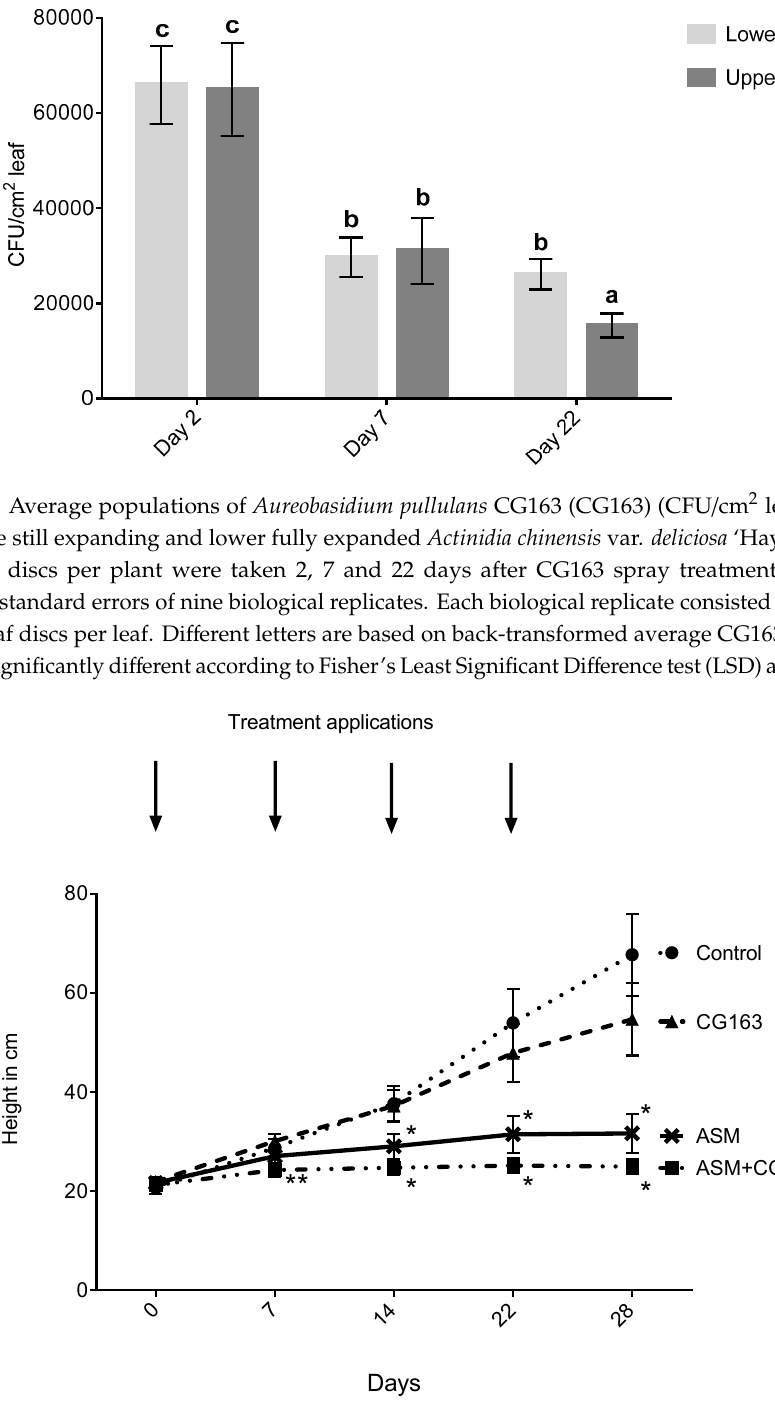
Figure 4. Plant growth of Actinidia chinensis var. deliciosa ‘Hayward’ potted plants treated with acibenzolar-S-methyl (ASM), Aureobasidium pullulans strain CG163 (CG163), combination of ASM and CG163 (ASM + CG163) or untreated (control). Weekly application of the treatments was started at T = 0 days and continued until T = 22 days. Weekly measurements of plant height were taken, measuring from the bottom of the stem near the soil to the tip of the stem. Values are means ± standard errors of treatments based on back-transformed average plant length (**: ASM + CG163 statistically di ff erent from CG163, *: ASM and ASM + CG163 both statistically di ff erent from CG163 and untreated control) according to Fisher’s Least Significant Di ff erence test (LSD) at the 5%